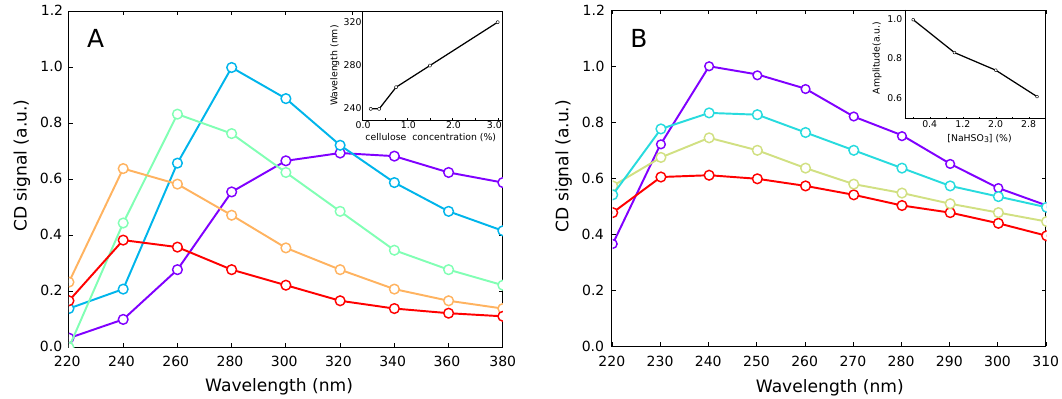
Figure 5. Circular-dichroism spectra of the cellulose hydrosols of different concentration ( A ), and in the presence on sodium hydrosulfite ( B ). ( A ) purple—3.0% of cellulose by weight, blue—1.5%, green—0.75%, orange—0.38%, and red—0.19%. Inset: position of the maximum as a function of cellulose concentration. ( B ) violet—pure cellulose hydrosol, cyan—1.0% of NaHSO 3 by weight, yellow—2.0%, and red—3.0% (cellulose concentration, 0.38%). Inset: spectra maximum amplitude as a function of NaHSO 3